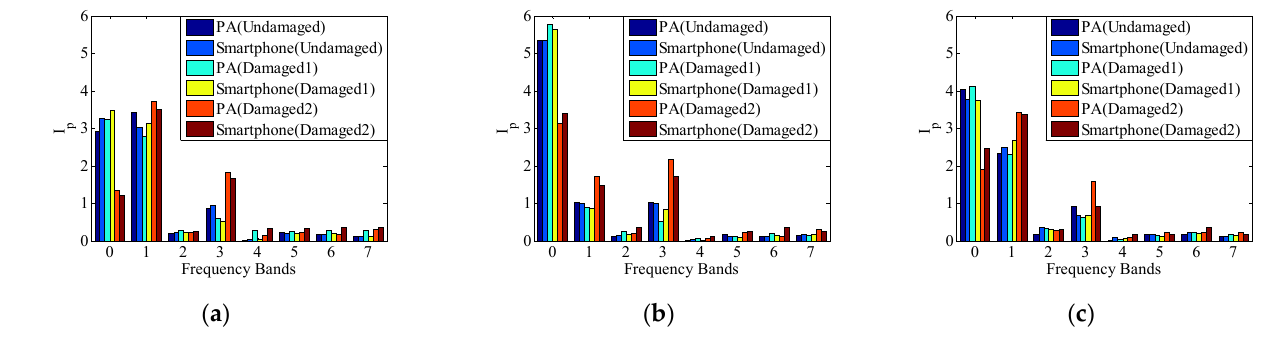
Figure 7. I p calculated for the ( a ) first, ( b ) second, and ( c ) third floors. Table 3. ERVD for different cases and for each story.